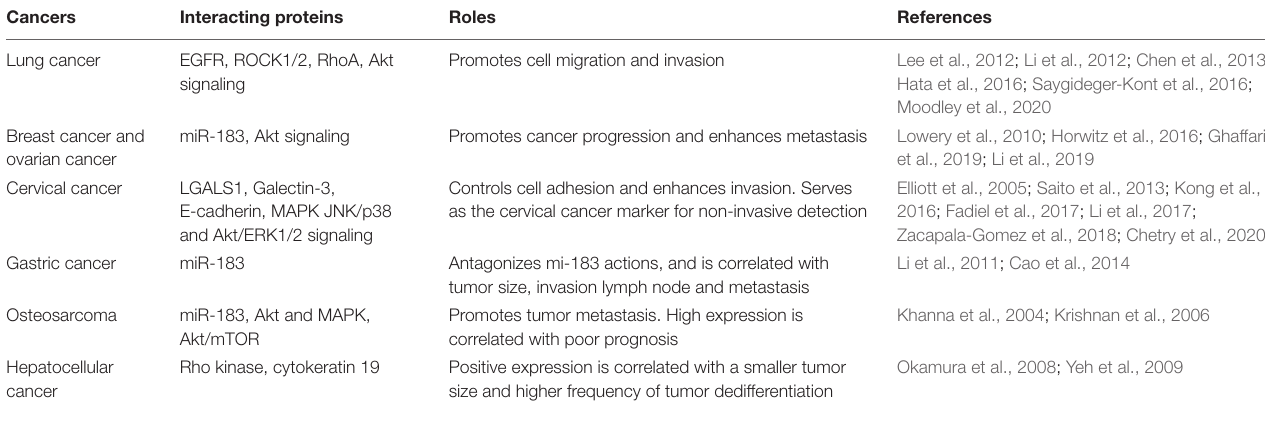
FIGURE 3 | Ezrin mediated signaling pathways and its pharmacological inhibitors. TABLE 2 | Selective Ezrin interacting proteins in various